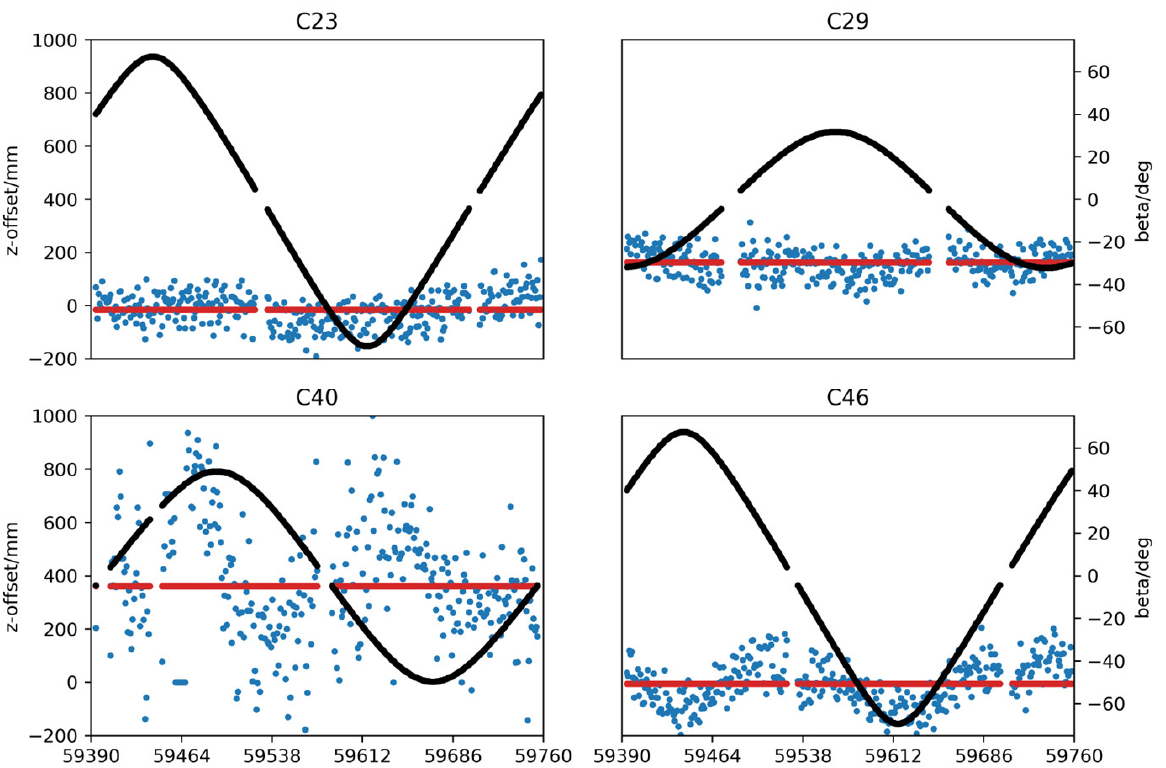
Figure 4. The z-offset time series of C23, C29, C40, and C46, respectively. The blue dots are z-offsets, the black dots are the beta angles, and the red dots are the derived z-offsets.